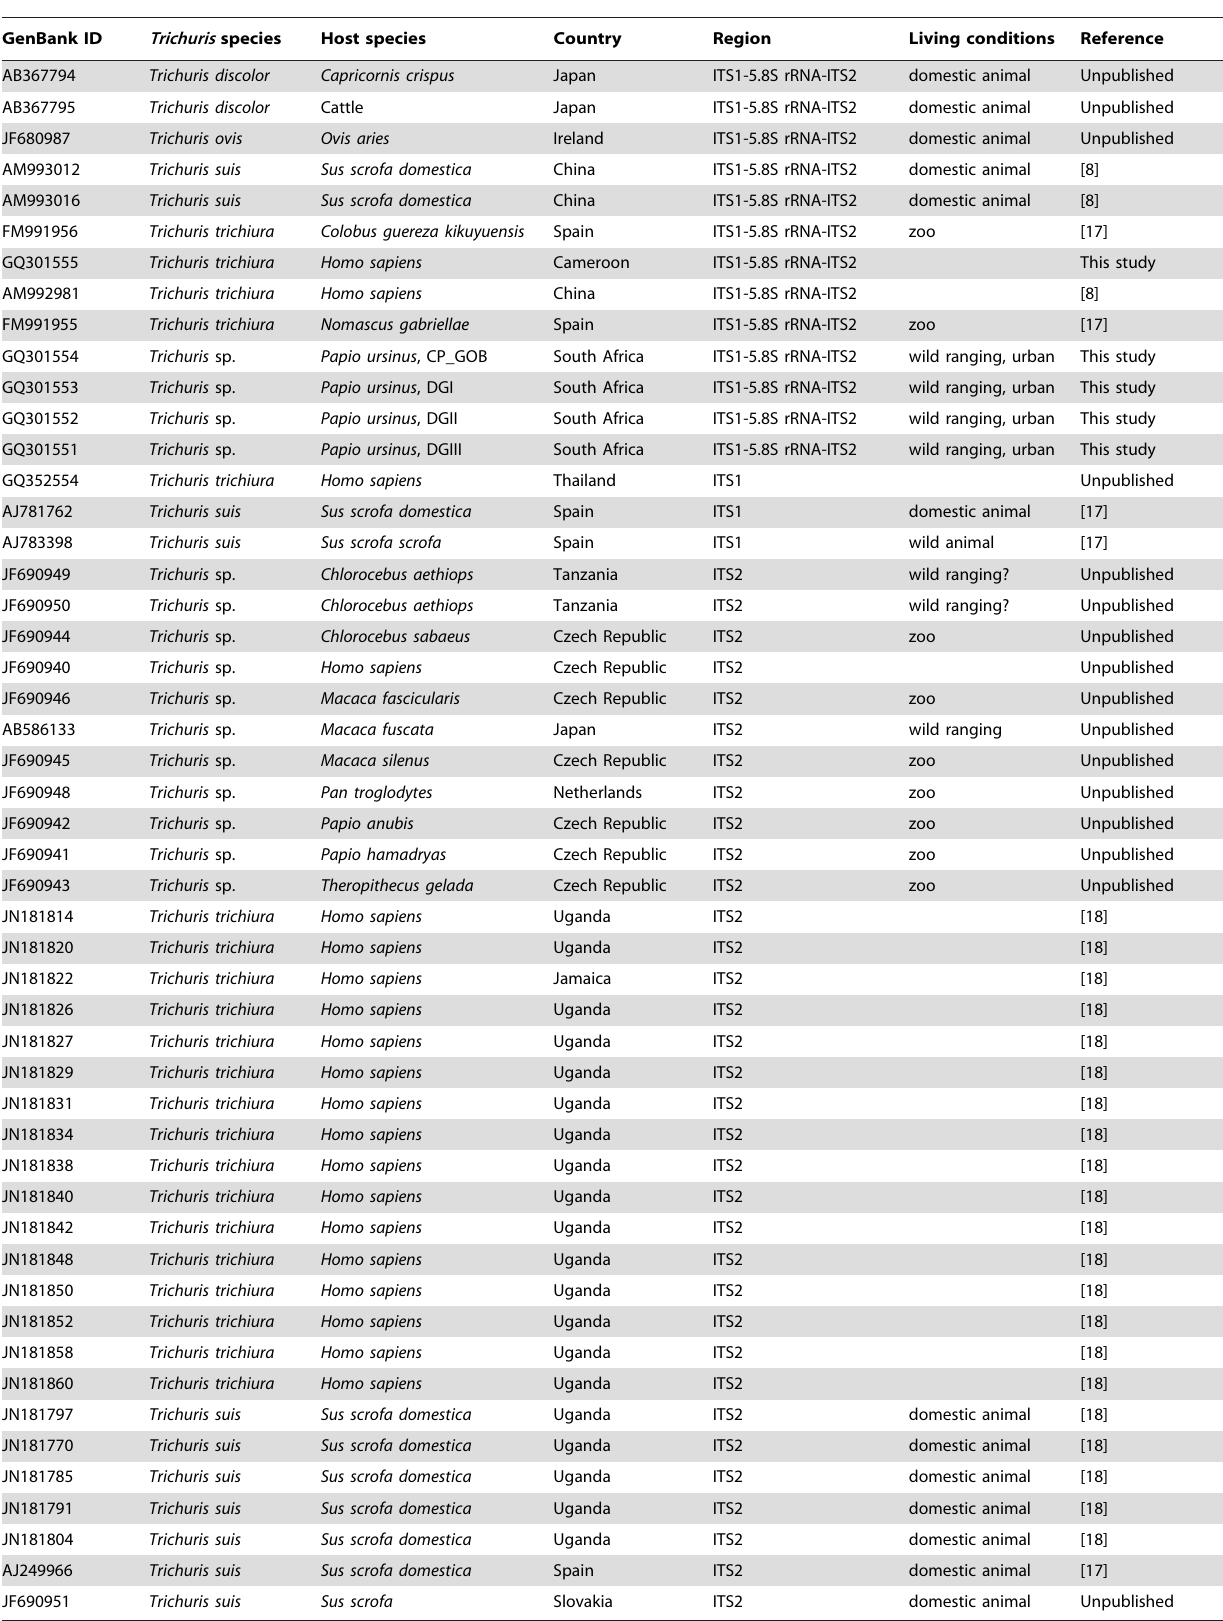
Table 1. GenBank Accession Numbers for full length ITS1-5.8S-ITS2 and ITS1 and ITS2 regions used in this study.